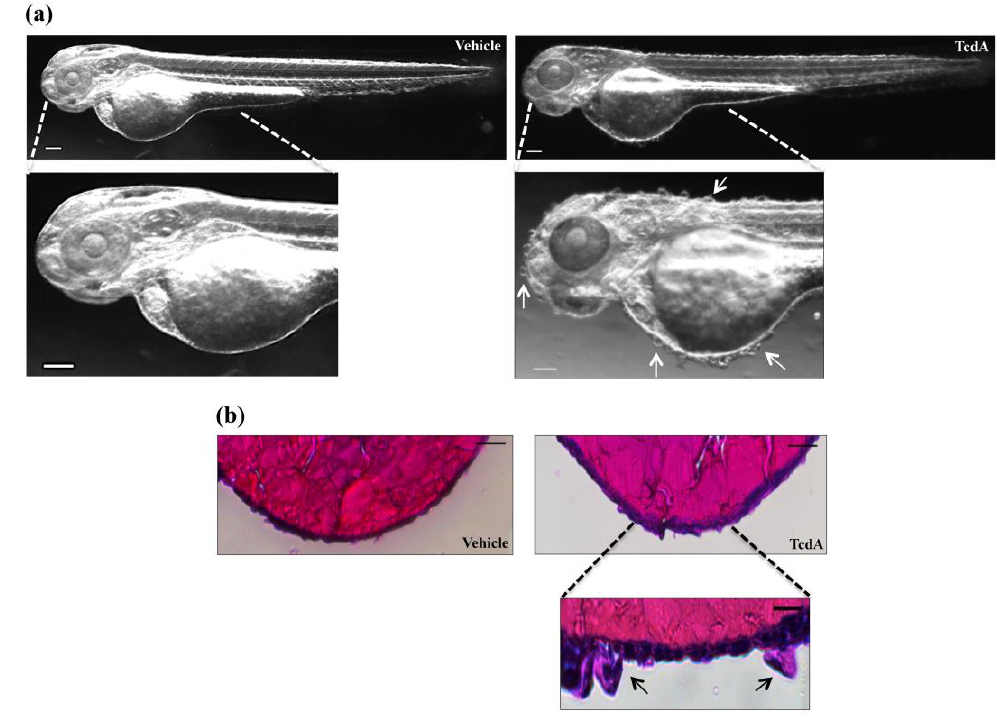
Figure 7. TcdA administration induced skin alteration in zebrafish embryos. ( a ) Representative images of 2.5 µ g / mL TcdA- or vehicle-treated embryos. Images were acquired with a Leica S8AP0 stereo microscope. Scale bar = 100 µ m. ( b ) Hematoxylin and eosin staining is performed on 2.5 µ g / mL TcdA- or vehicle-treated embryos to evaluate skin structure. Scale bar = 100 µ m (upper panel). A magnification of the hypertrophic cell of the epidemical layer is taken from TcdA-treated embryo (lower panel; scale bar = 10 µ m). Images were acquired with a Leica S8AP0 stereo microscope.